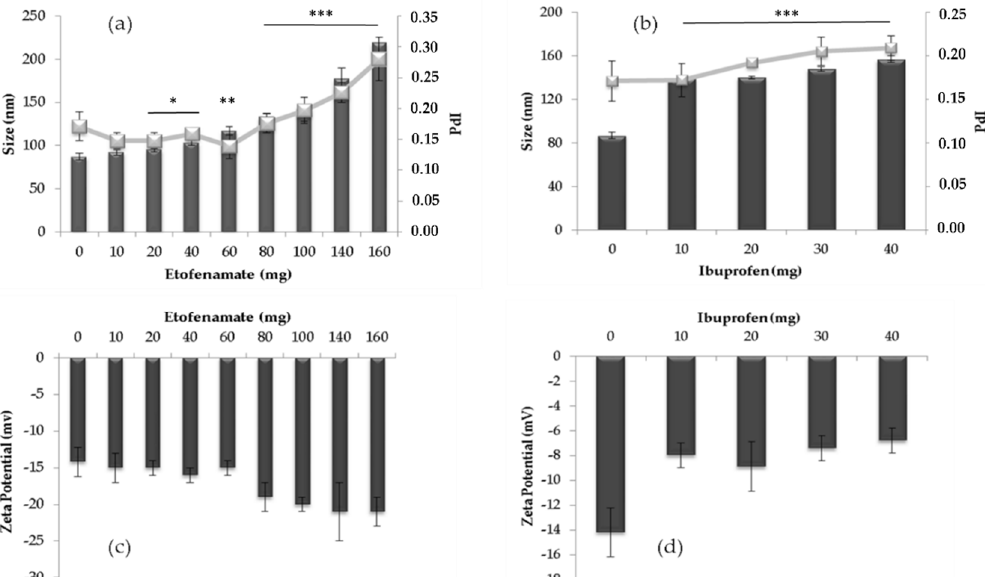
Figure 2. ( a , b ) Mean particle size (bars) and polydispersity index (PdI) (lines) and and ( c , d ) zeta potential of etofenamate- SLN and ibuprofen-SLN. Statistical significance is presented only for size. All the data were compared to the absence of a drug. The level of significance was set at the probabilities of * p < 0.05, ** p < 0.01 and *** p < 0.001. Results represent the mean ± S.D.; n = 3.